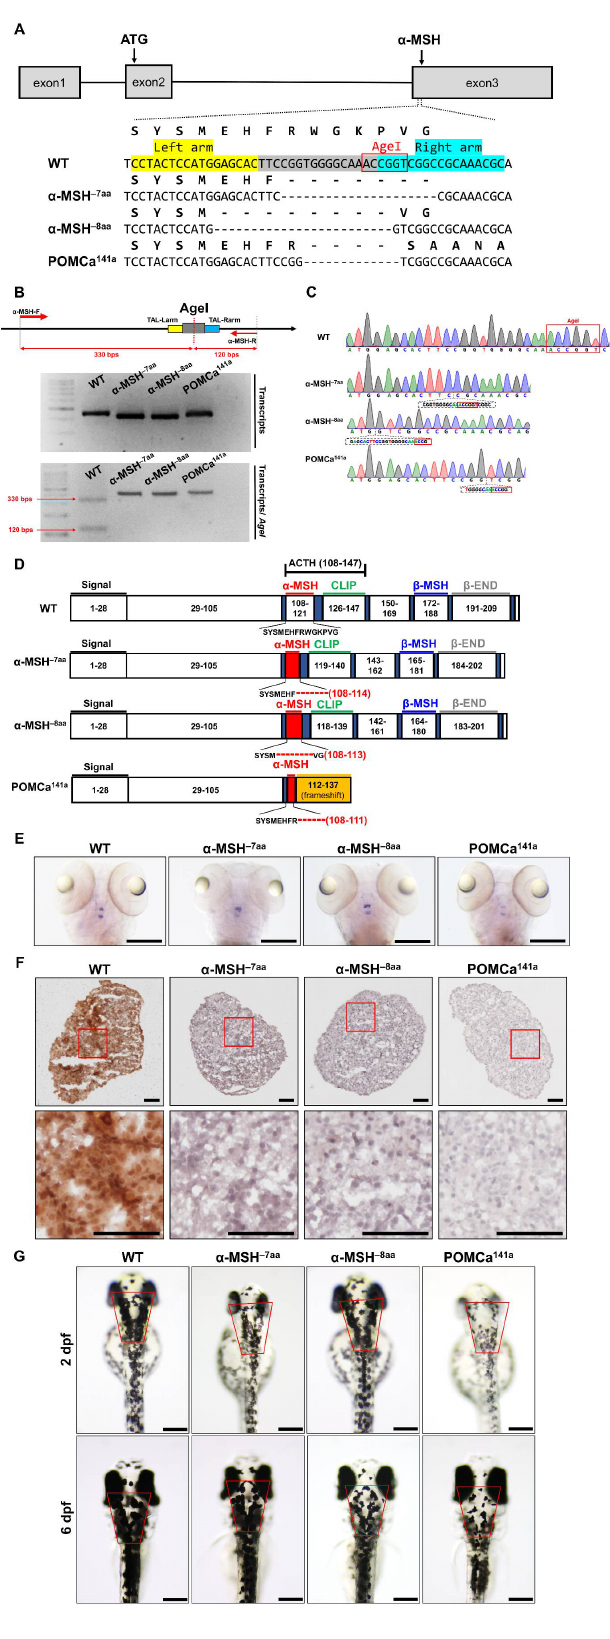
Figure 1. Generation of zebrafish pomca mutants using TALEN. ( A ) Schematics of the three pomca mutant alleles generated. The sequences in the third exon that were targeted by the TALEN